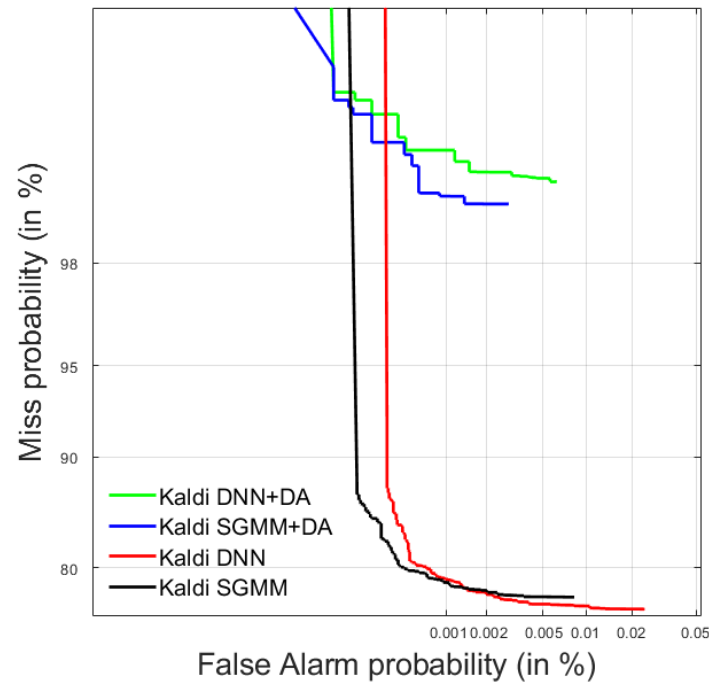
Figure 6. DET curves of the STD systems for RTVE test data.